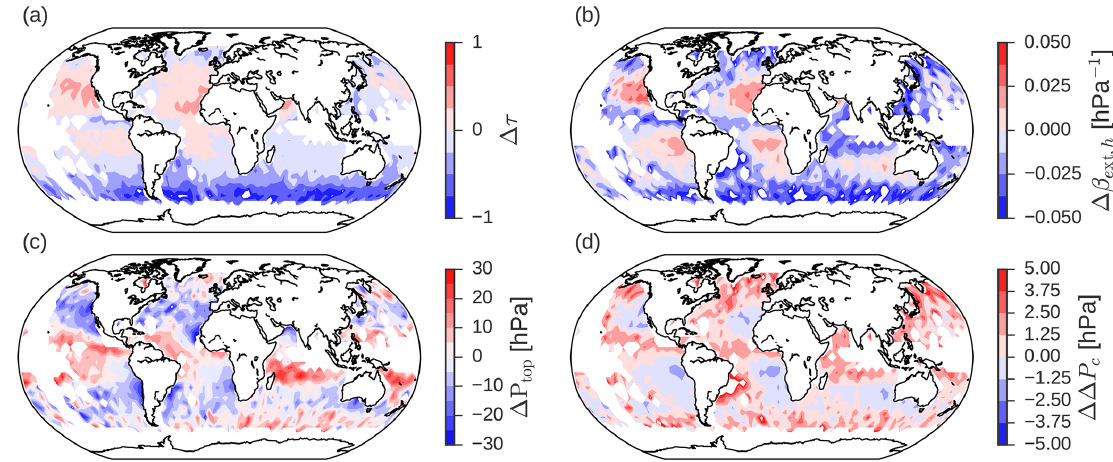
Figure 13. Changes in retrieved properties as posterior minus prior, for Quality_flag = 0 retrievals, mean value in each 4 ◦ × 4 ◦ latitude– longitude grid